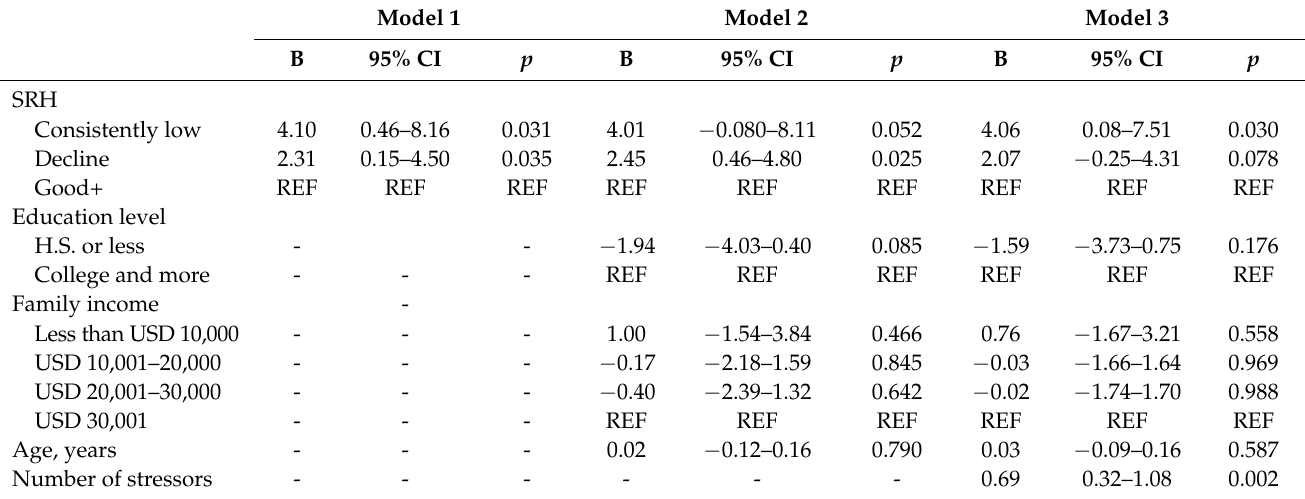
Table 3. Crude and Multiple Adjusted Linear Regression Models Examining Associations between Changes in Self-Rated Health and Prenatal Depressive